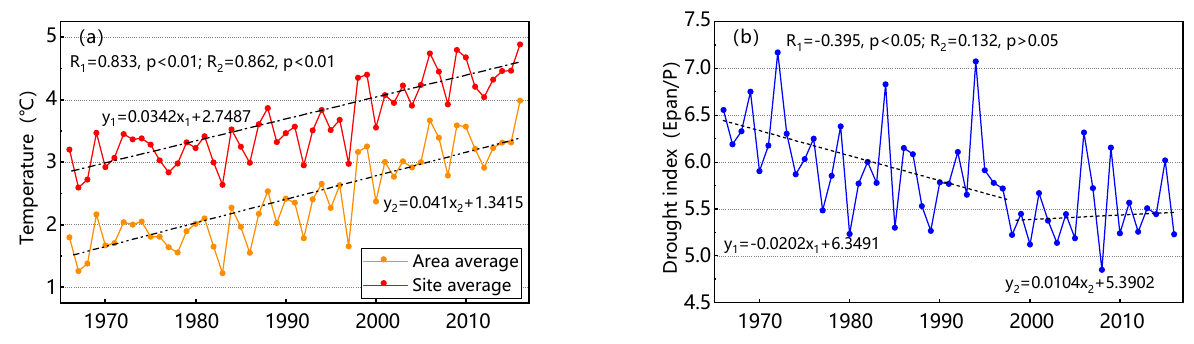
Figure 14. Interannual trends of the average temperature ( a ) and the drought index ( b ) on the TP. In terms of spatial differences, precipitation was concentrated at lower elevations in the eastern and southern portions of the TP, where rivers were extensively developed, and decreased from southeast to northwest, whereas Epan had larger values in the southwest and northeast TP, decreasing from the northern and southern ends toward the mid- latitudes of the plateau. The varying levels of solar radiation and air water vapor content were the key contributors to this phenomenon [23]. The main way that solar radiation affected the insolation conditions at the surface was cloud cover [34]. The dense cloud cover in the TP mid-latitudes reduced the amount of net radiation received by the surface, and the lack of sufficient energy-driven conditions for water evaporation caused Epan to tend to be small [33]. On the other hand, the crucial indication for preserving the air–water